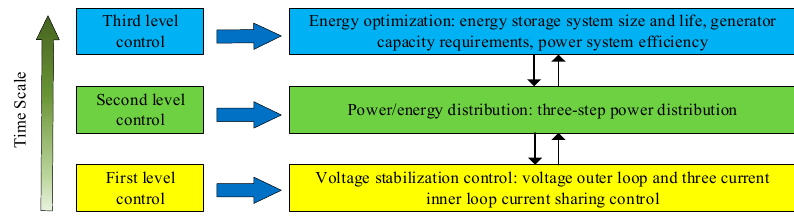
Figure 3. The overall control goal of energy management.